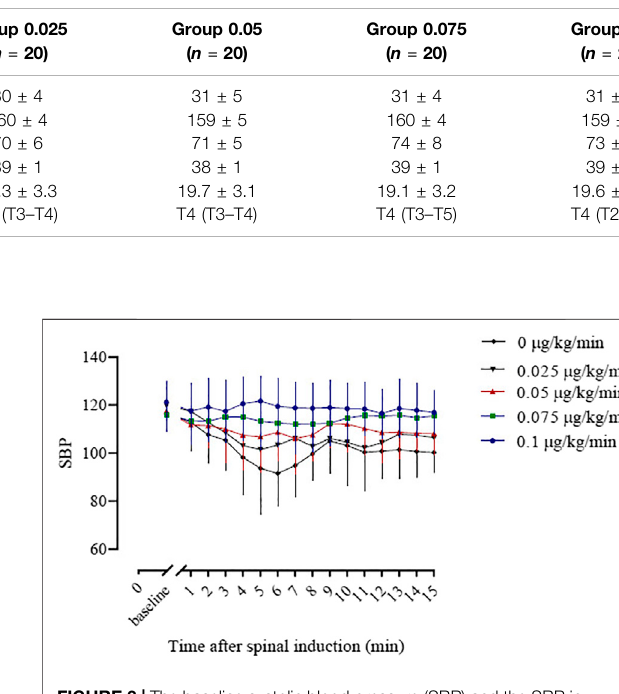
FIGURE 3 | The baseline systolic blood pressure (SBP) and the SBP in the fi rst 15 min after spinal induction is presented for the fi ve groups. The area under the curve (mean ± SD) was signi fi cantly different among the groups (2,309 ± 33, 2,067 ± 34, 1,653 ± 25, 1,584 ± 31 and 1,572 ± 36 min × mmHg in groups 0, 0.025, 0.05, 0.075, and 0.1, respectively, p <